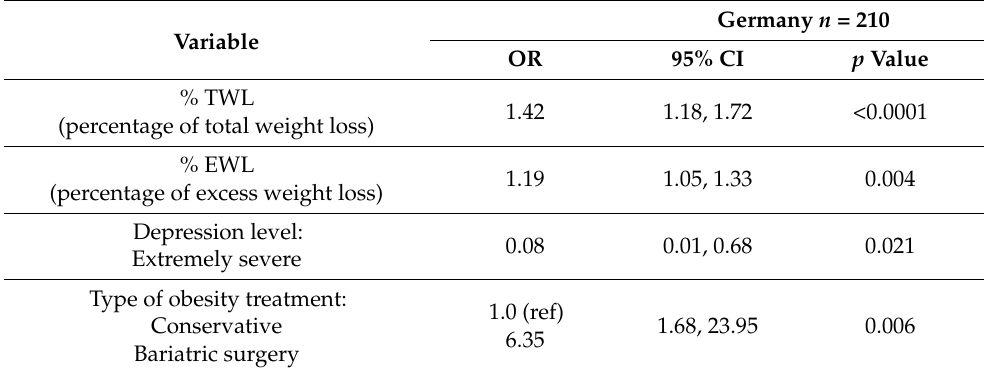
Table 6. Multiple logistic regression model results for the risk factor of adherence in the field of obesity treatment in Germany ( n =